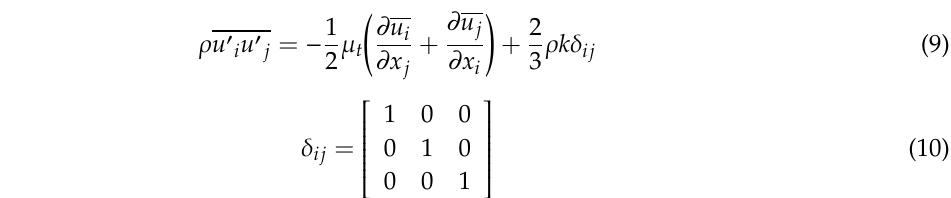
Figure 3. Calculation grids. ( a ) Local grid refinements near the edge of the diffuser throat; ( b ) Topology of the mesh. Unsteady numerical simulations also based on RANS method were applied in the present study. Considering the grid-scale and the Courant number requirement, i.e., C = u∆t / ∆s < 10 (where u , ∆t , and ∆s are the characteristic flow velocity, the time step size and typical cell size, respectively),  t was set as 0.001 s. The maximum number of iterations was set as 20. Simulation convergence was achieved when the residual error was lower than 10 −6 , or the variation of the operational parameter C PR was below 0.01%. For the purpose of measuring the operational parameter C PR , static pressure monitors were set to record the average static pressure of the diffuser inlet and